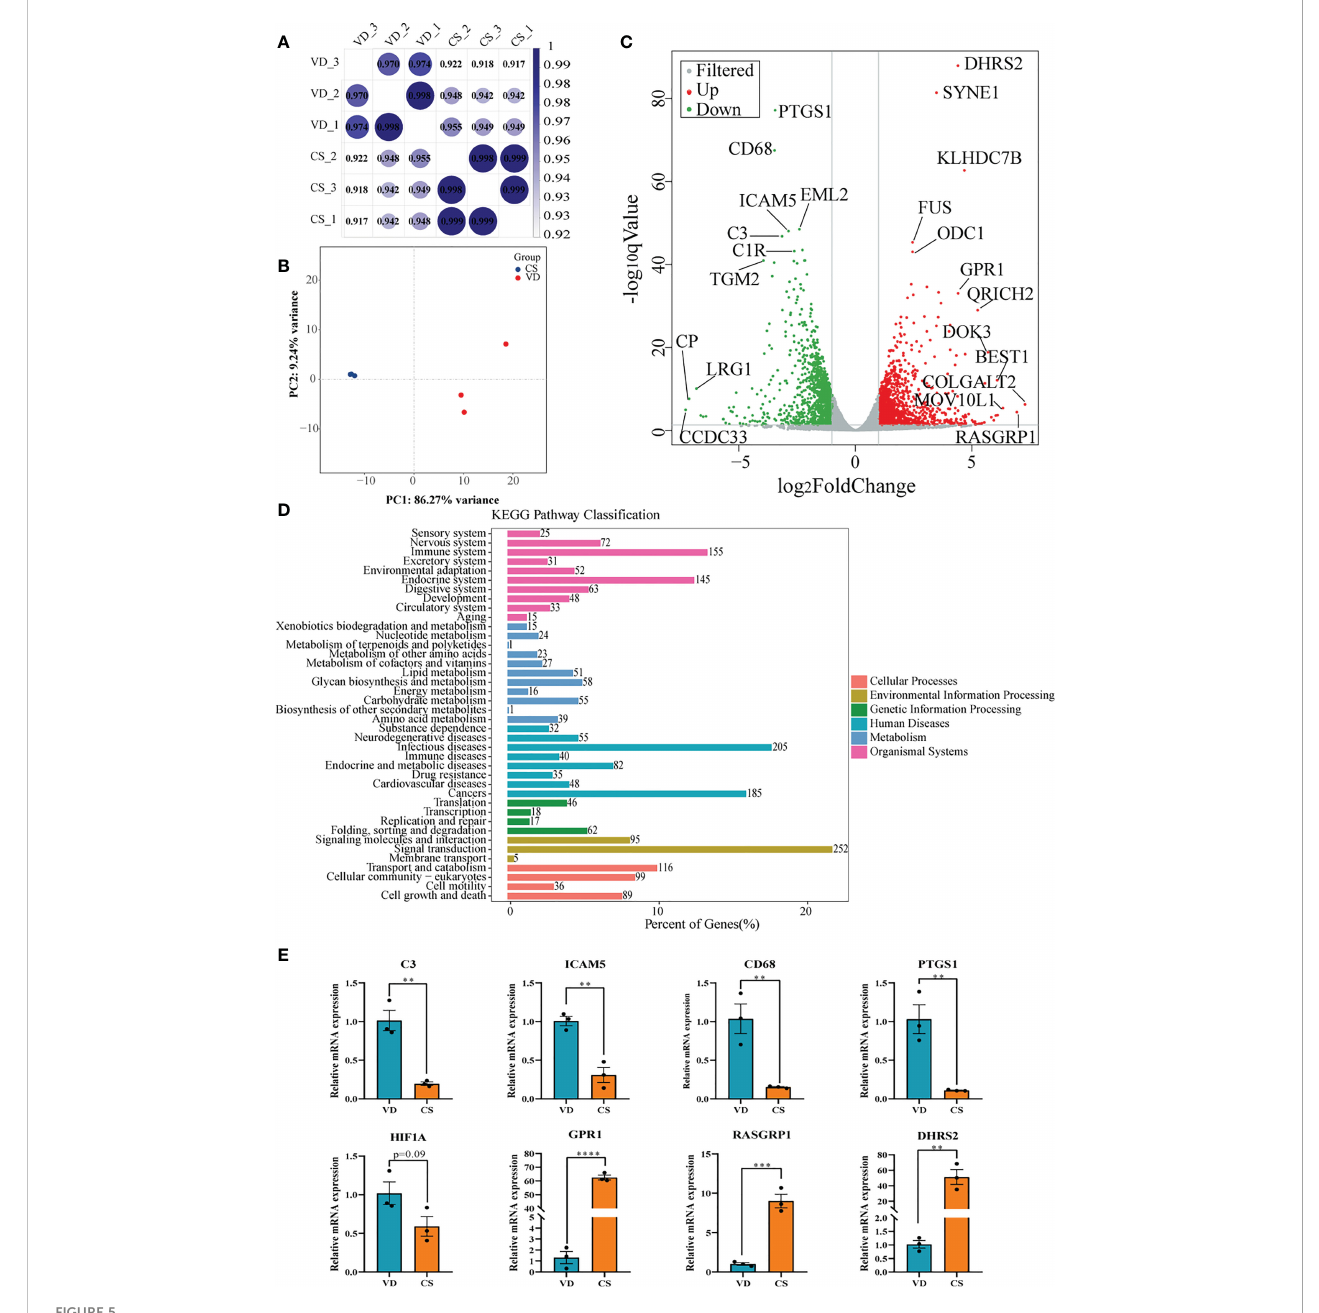
FIGURE 5 Transcriptome analyses of human intestinal epithelial NCM460 cells after CS AF stimuli. (A) , Correlation heatmap analysis between CS AF-treated cells (n = 3) and VD AF-treated cells (n = 3). (B) , PCA score plots for differentiating the genes in each group. (C) , Volcano plot showing the differentially expressed genes (DEGs) in the CS AF-treated group (n = 3) and VD AF-treated cells (n = 3). Red dots represent the DEGs up-regulated in the CS AF- treated cells, and green dots represent the DEGs down-regulated in the CS AF-treated cells. (D) , KEGG classi fi cation analysis of DEGs. (E) , Validation of DEGs between CS AF-treated group (n = 3) and VD AF-treated group (n = 3) using RT-qPCR. The change in fold-expression was calculated by the 2- ΔΔ CT method using GAPDH as a reference gene. Error bars represent SEM. **p < 0.01, ***p < 0.001, ****p <